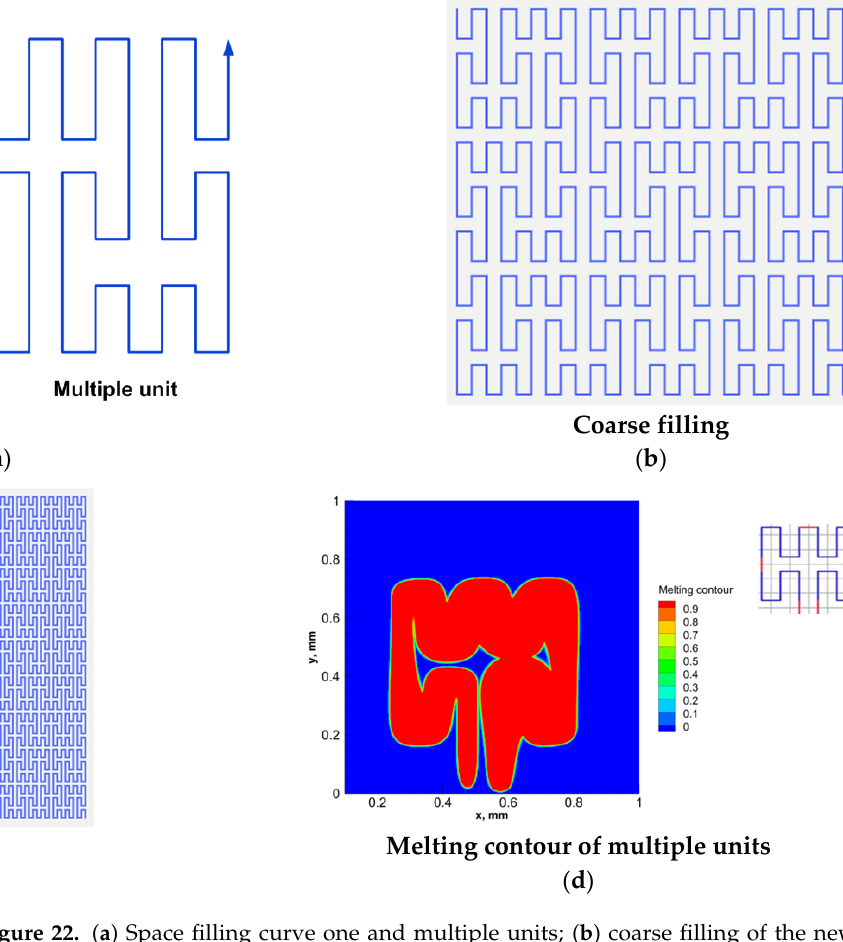
Figure 22. ( a ) Space filling curve one and multiple units; ( b ) coarse filling of the new proposed scanning strategy; ( c ) fine filling of the new proposed scanning strategy; ( d ) melting contour of multiple space filling cure unit.